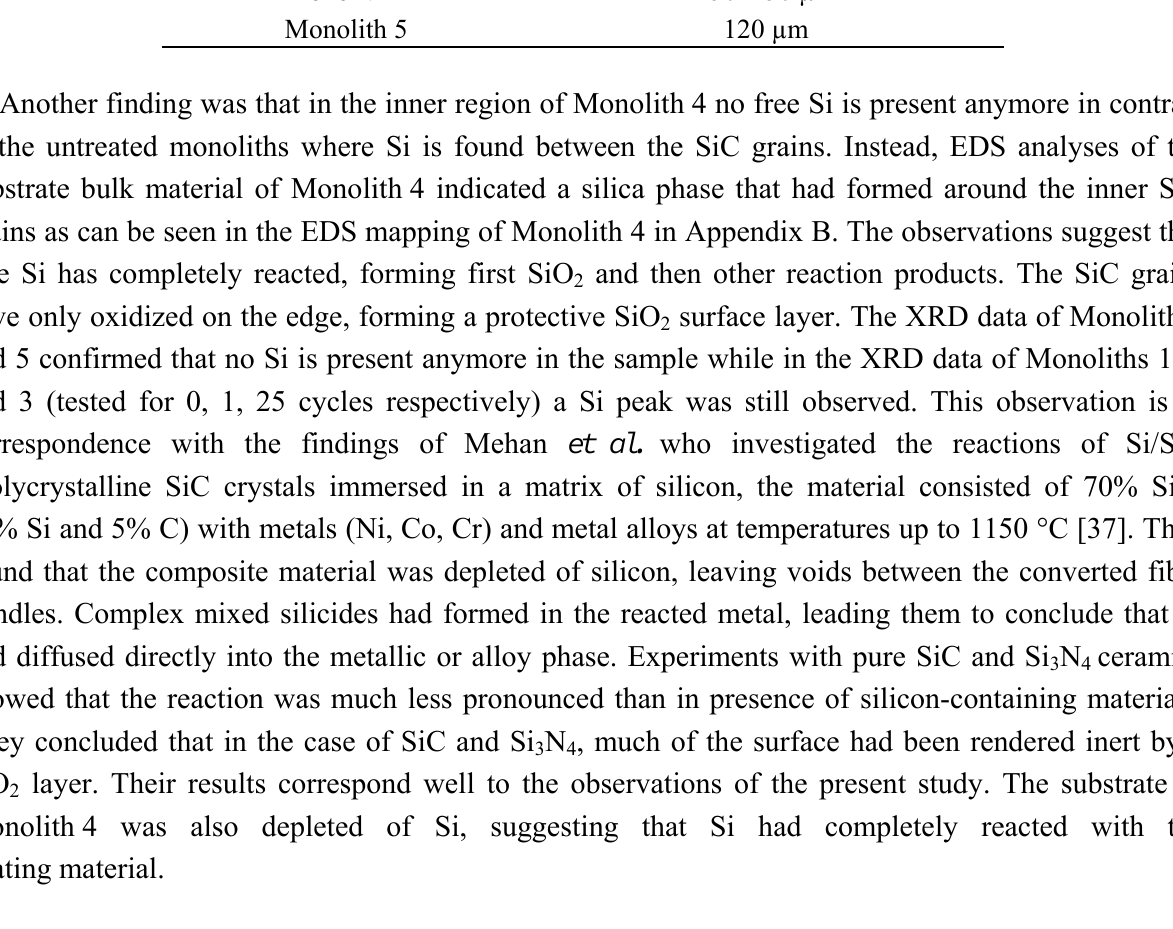
Table 4. Thickness of ZrSiO